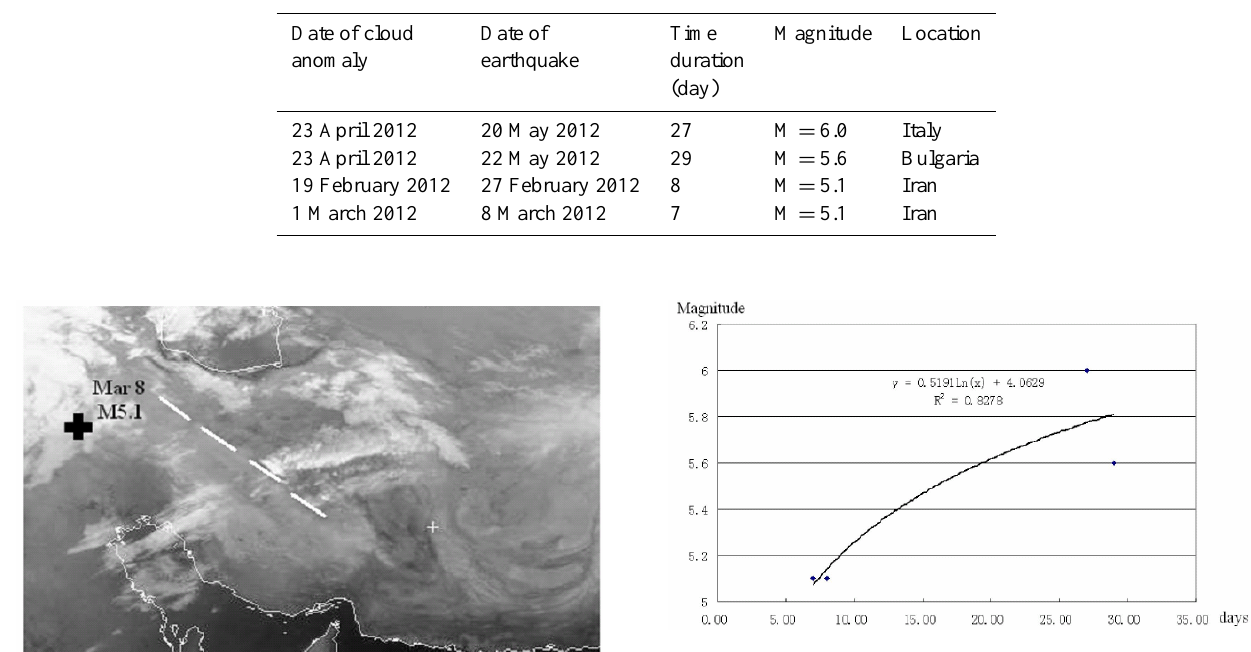
Figure 4. Scatter map of four earthquakes preparation time and magnitude Fig. 4. Scatter map of four earthquake’s preparation time and mag-